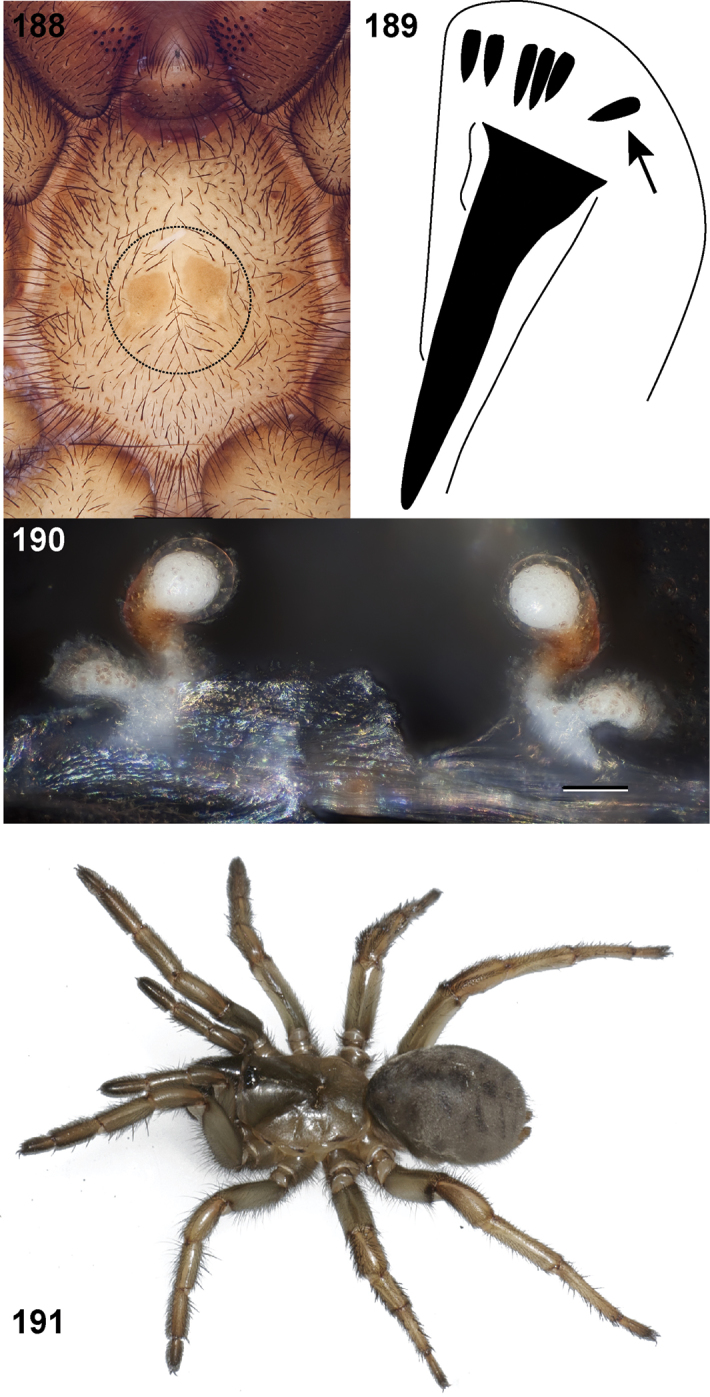
Aptostichus hesperus (Chamberlin, 1919). 188 sternal sigilla pattern (indicated by circled area, labium at top of photograph; MY2526)) [805941] 189 line drawing of rastellar spine pattern for Aptostichus hesperus and other Hesperus group species 190 cleared spermathecae, specimen from San Bernardino Co., Yucaipa (MY2526) [805942]; scale bar = 0.1mm 191 photograph of live specimen from Riverside Co., Winchester(MY2496).